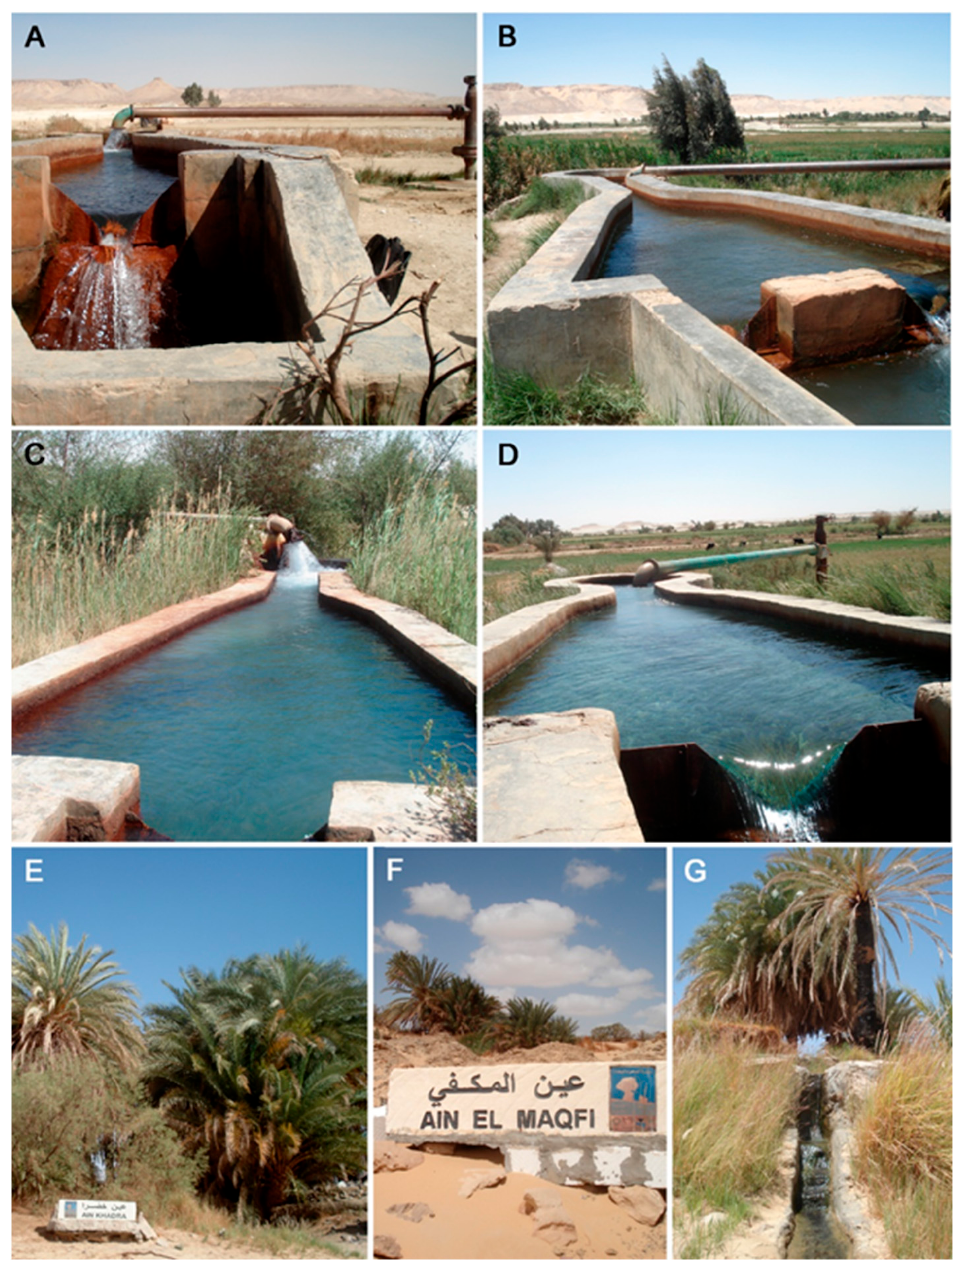
Figure 2. Photographic views of some important groundwater springs and drilled wells in El-Farafra Oasis. ( A ): Bir 7 (Lewa Soubah village); ( B ): Bir 4 (El-Nahda village); ( C ): Bir 150 (El-Nahda village); ( D ): Bir Kamel (El-Nahda village); ( E ): Ain Khadra “also named Ain El-Wadi” (The White Desert National Park); ( F ): Ain Maqfi “also called Ain Abu Hawas” (The White Desert National Park); ( G ): Ain El-Serw (The White Desert National